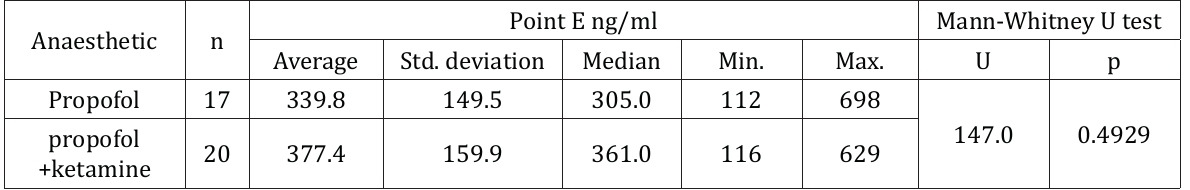
Table 14. Descriptive statistics – The concentration of MMP-9 at the end point among patients treated with different anaesthetics and the result of a Mann-Whitney U test